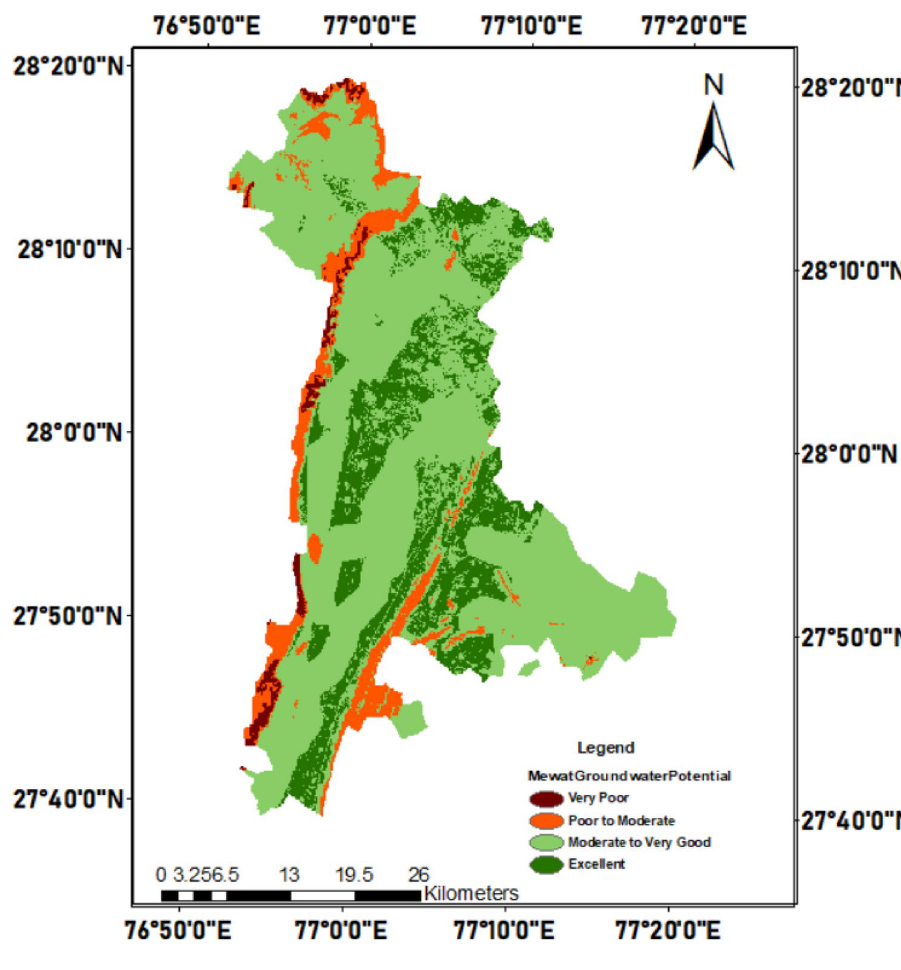
Fig. 9 Groundwater potential map of study